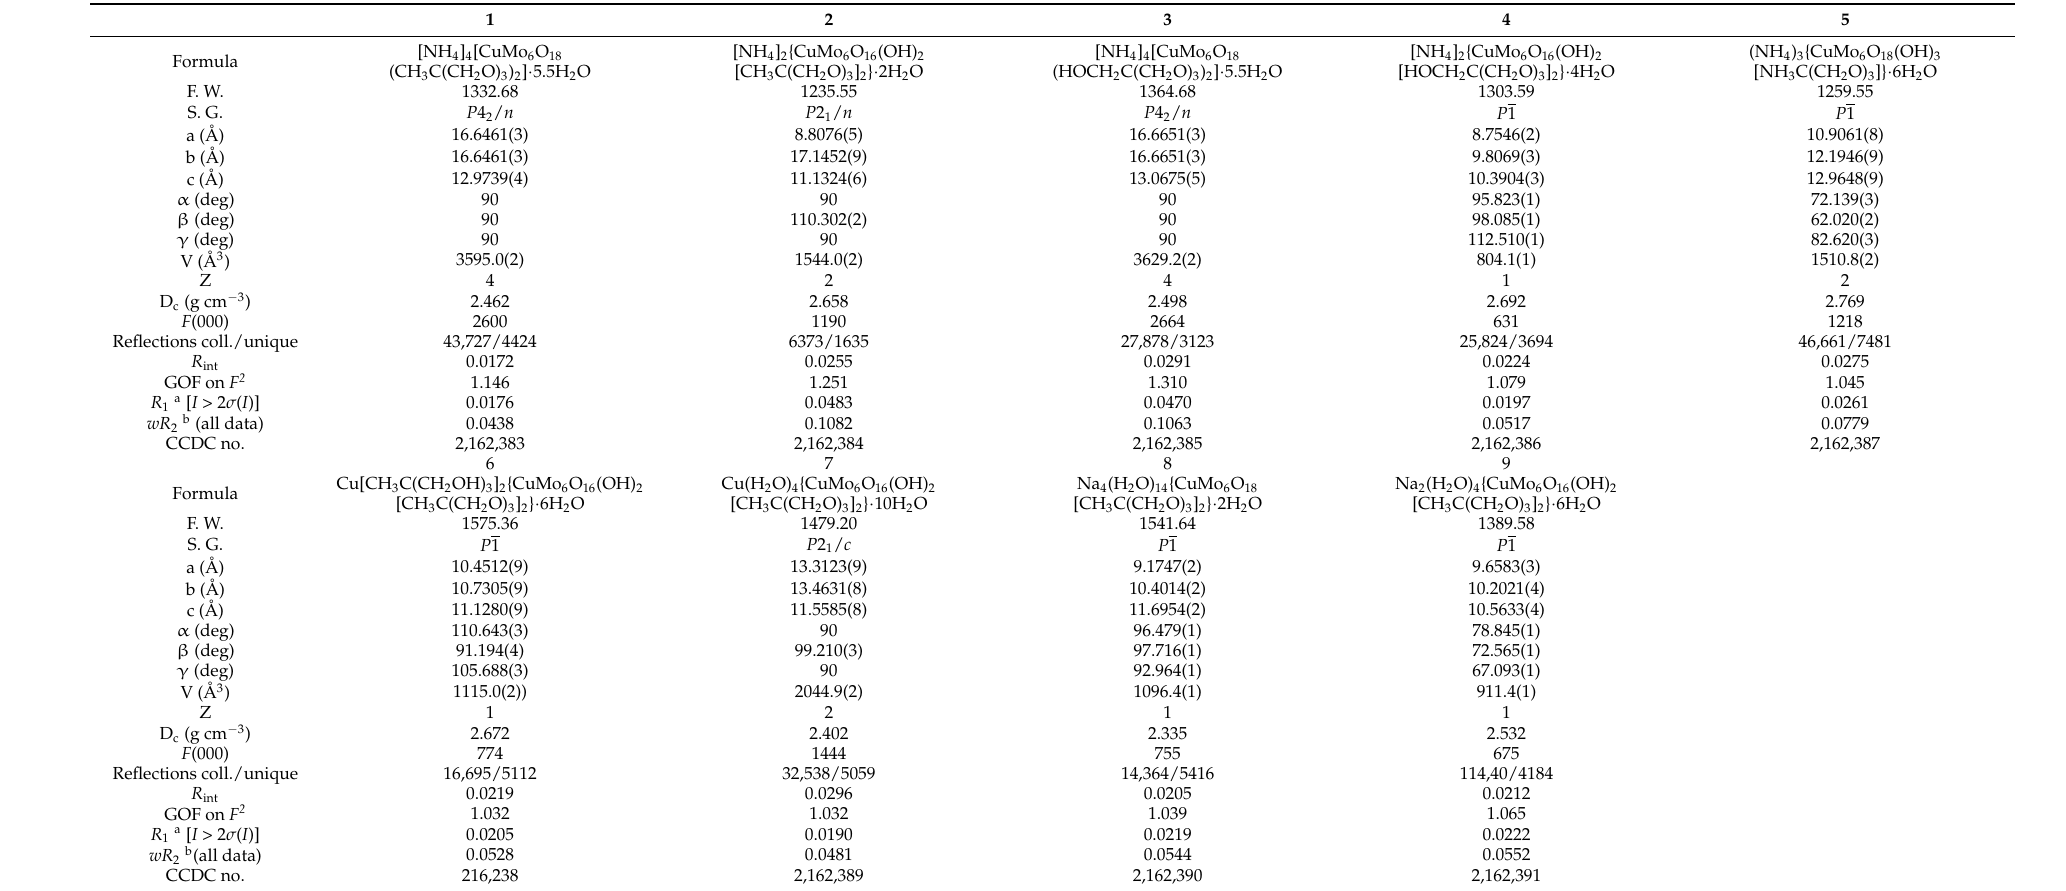
Table 1. The summary of crystal data and structure refinements for compounds 1 – 9